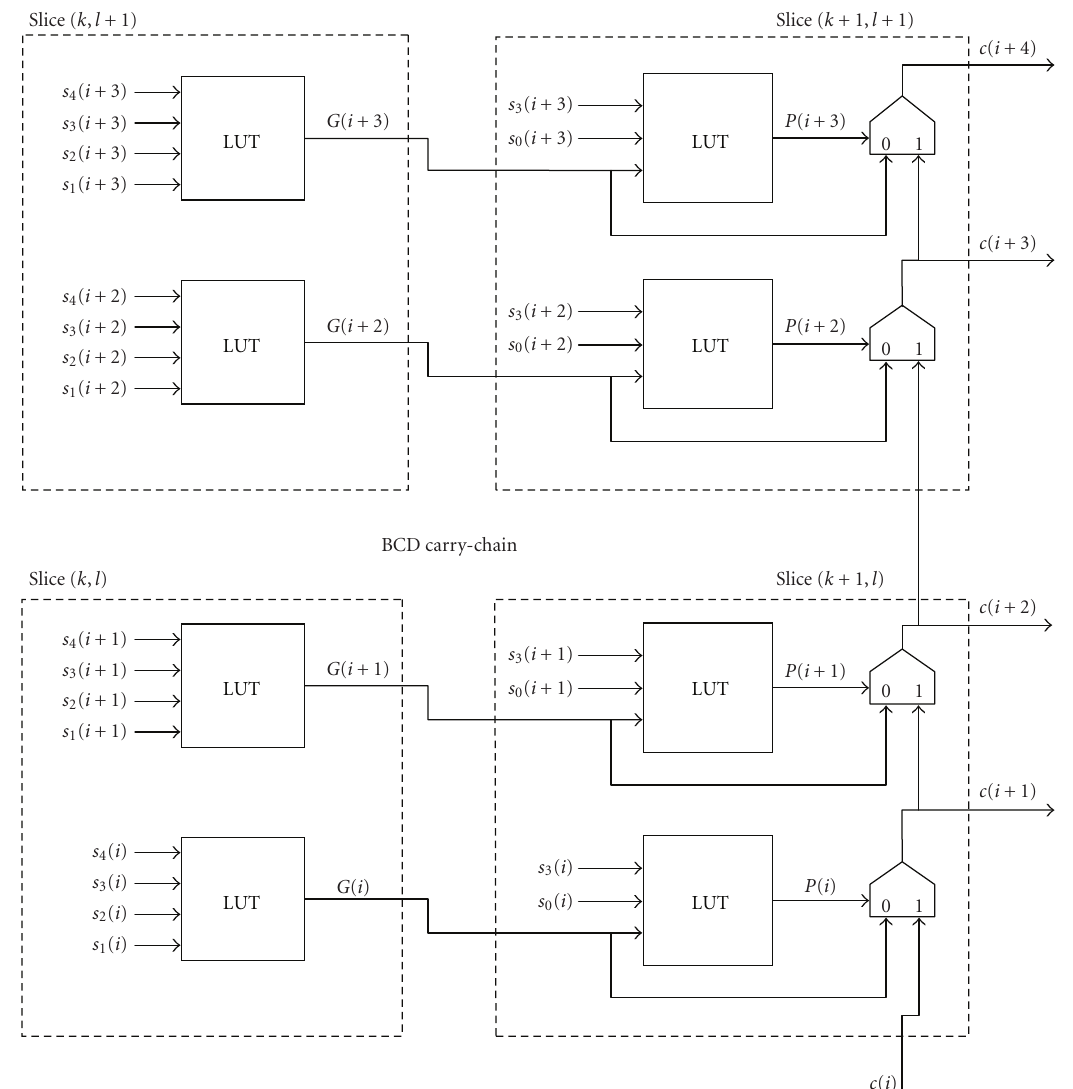
Figure 9: FPGA implementation of the carry-chain circuit ( GP a